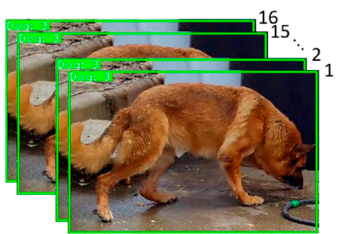
Figure 7. Dog image set.